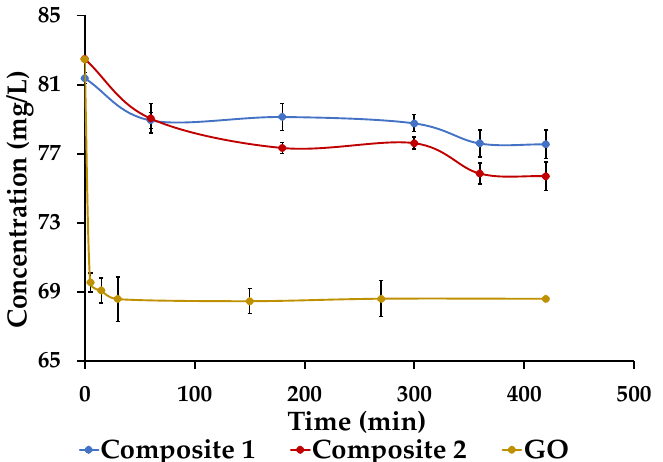
Figure 11. Adsorption kinetics for GO and the composites. [Pb(II)] = 80 mg / L; pH of the solution = 5; V = 50 mL; MSOLID = 5 mg; agitation = 250 rpm; T = 20 °C.